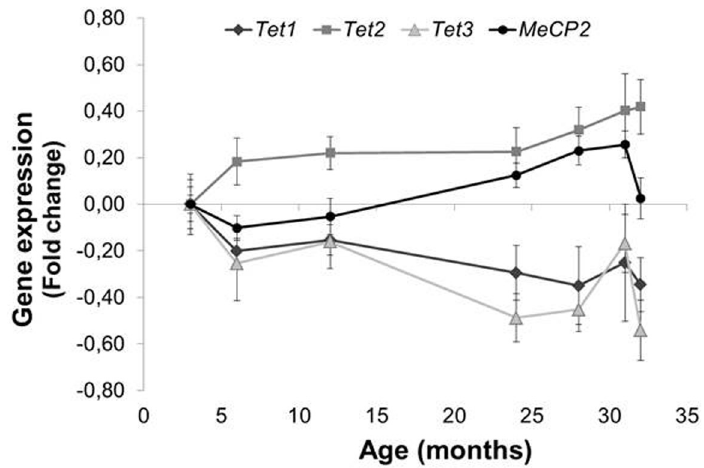
Figure 4. Expression of Tet1–3 and Mecp2 with ageing in mouse brain (* p = 0.050, ** p < 0.040, *** p = 0.026). Data are presented as the mean values ( n = 3–4), and bars indicate standard errors of the mean.